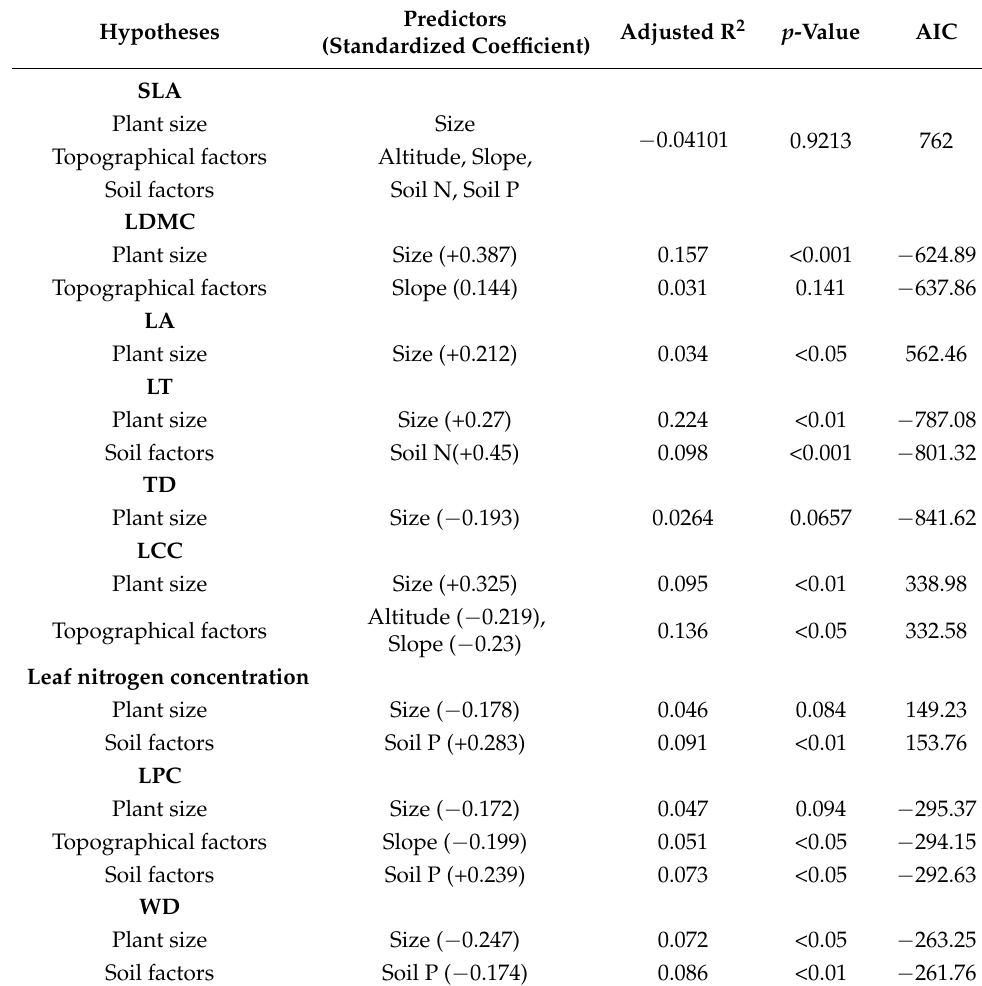
Table 4. Summary of the multiple regression models for the impact of plant size and environmental factors on functional